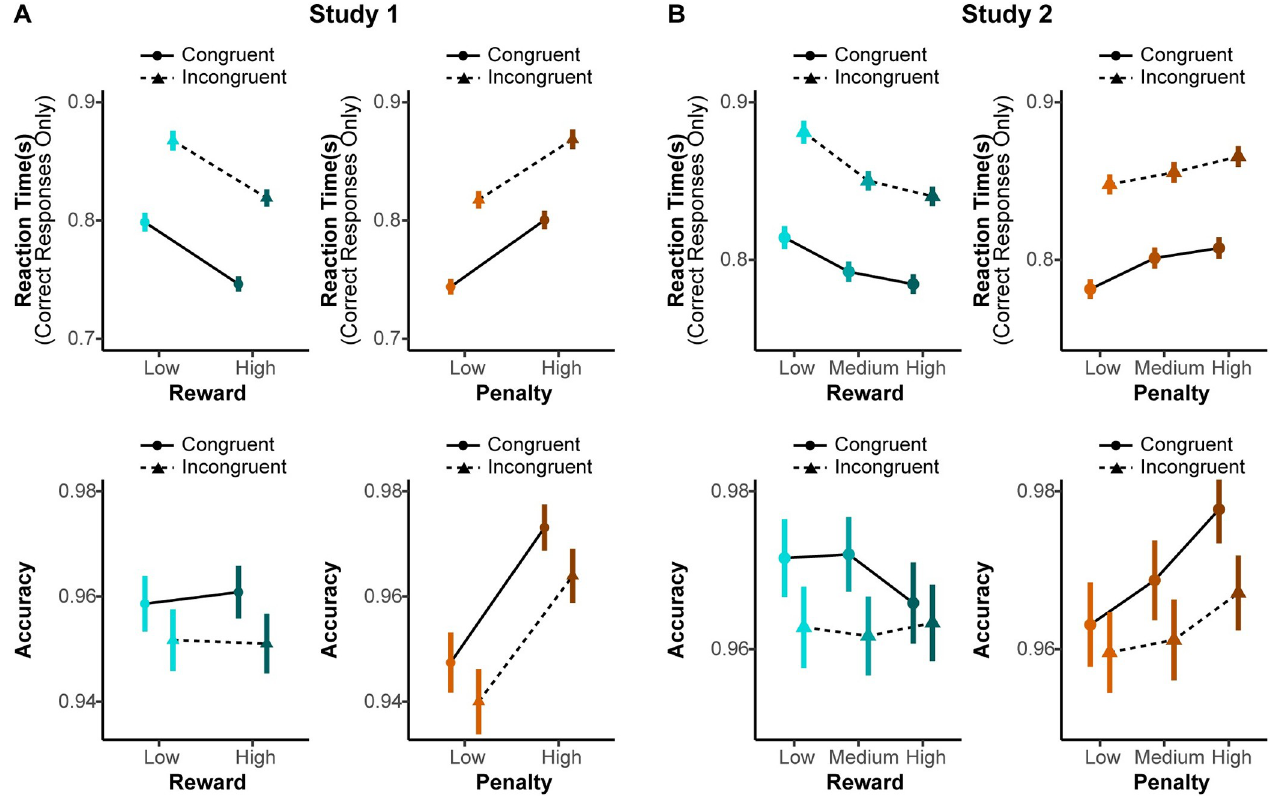
Fig 7. Effects of reward and penalty in congruent and incongruent trials. (A) Participants were faster and more accurate when responding to congruent stimuli compared to incongruent stimuli. The effects of reward and penalty on response time and accuracy are consistent across congruent and incongruent trials in Study 1. (B) Study 2 replicated these parallel influences of reward and penalty on congruent and incongruent trials, with only a marginal interaction between incentives and trial congruence observed for accuracy.